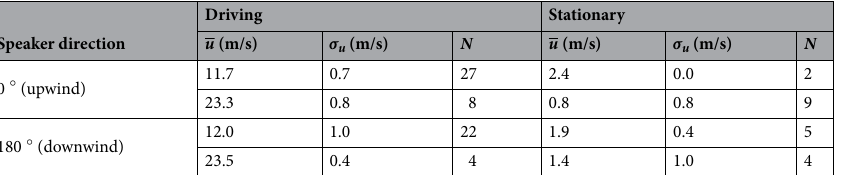
Table 2. Summary of mean measured wind speeds and standard deviations over the measurement segments used in the magnitude response analysis. Each averaging was done over N segments without taking the wind direction into